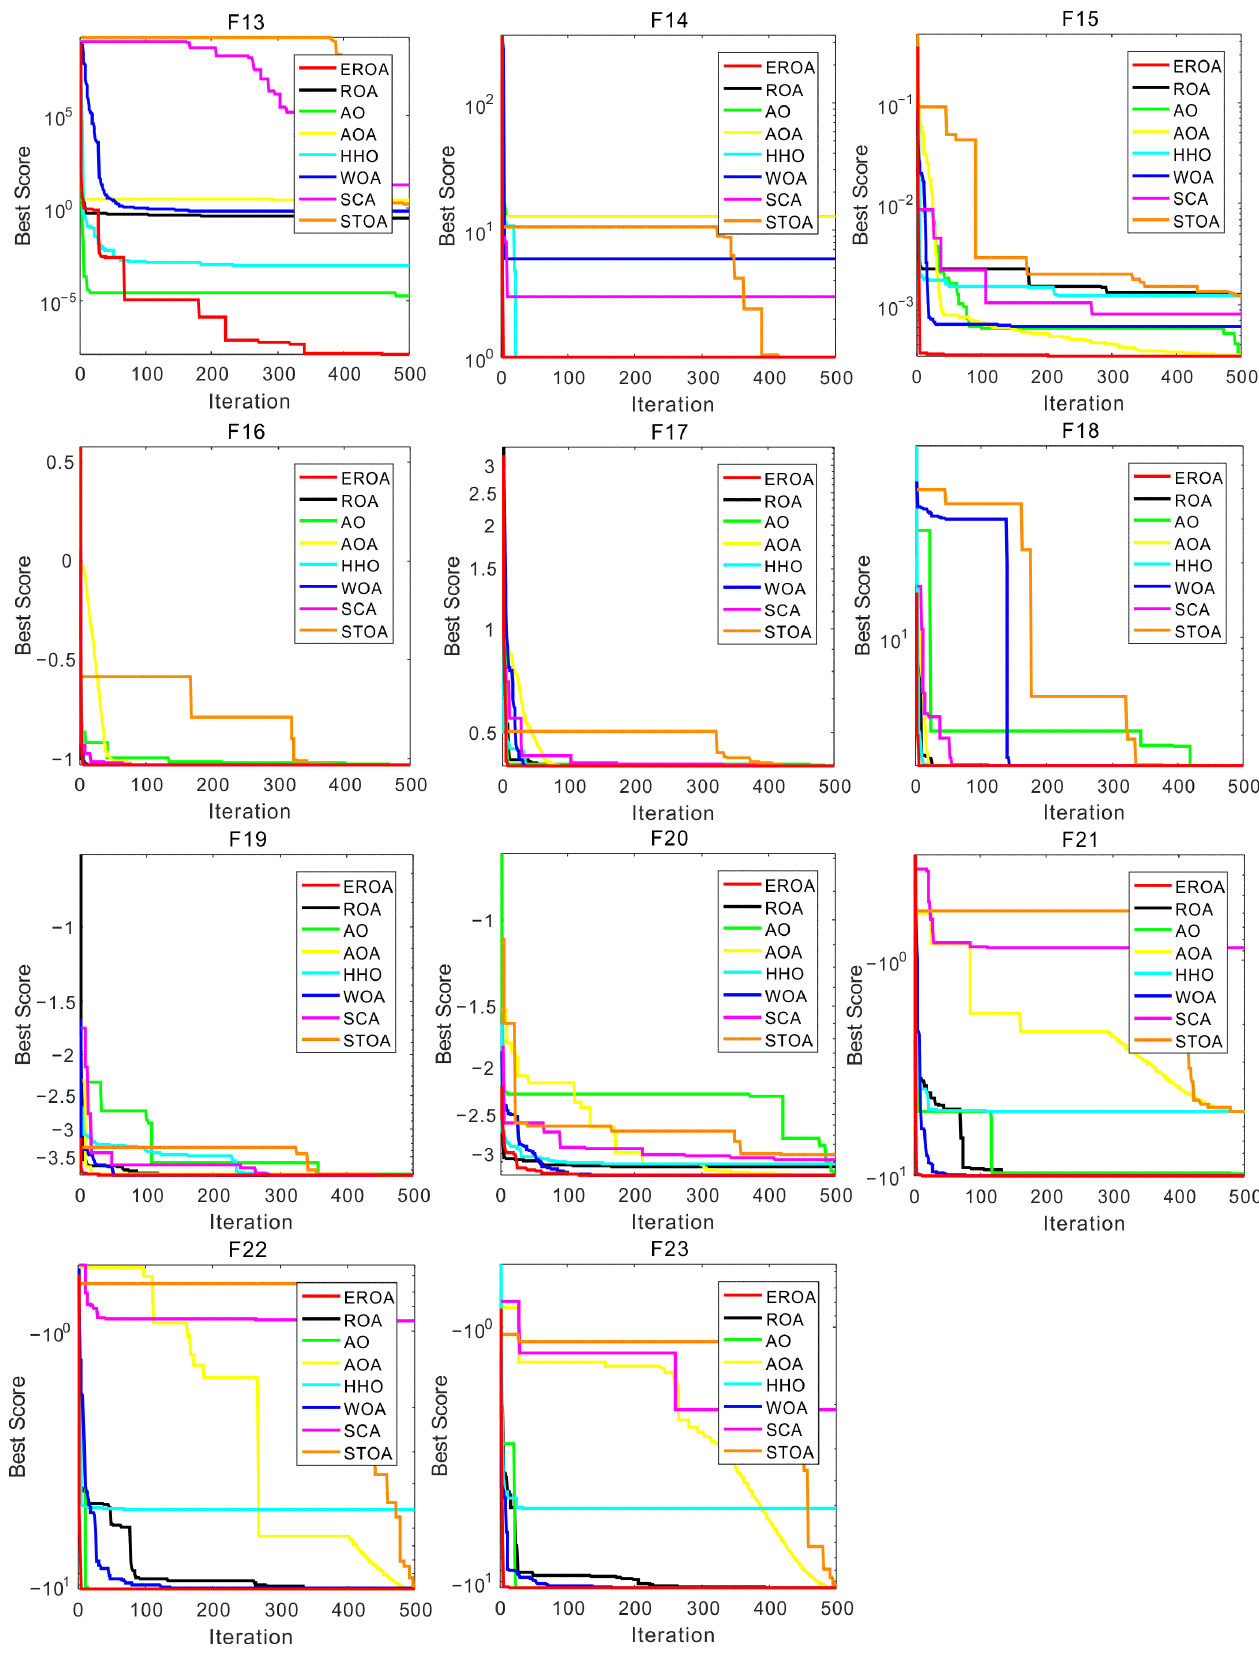
Figure 3. Convergence curves for the optimization algorithms for standard benchmark functions.